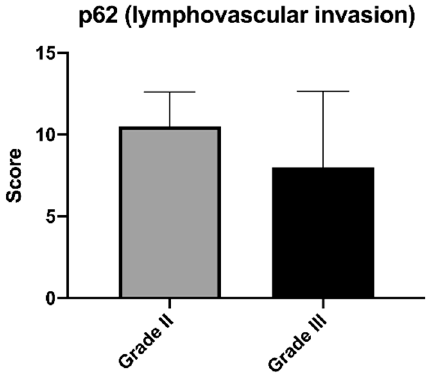
Figure 4. Mean ( ± SD) of the immunoreactivity score for p62 in the cases of feline mammary carcinoma Figure 4. Mean (±SD) of the immunoreactivity score for p62 in the cases of feline mammary with lymphovascular invasion considering the different grades of carcinoma with lymphovascular invasion considering the different grades of differentiation.